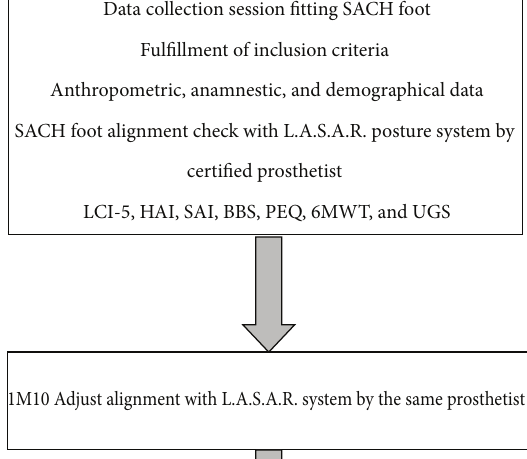
Figure 4: Box-plots for the nine subscales scores of the Prosthesis Evaluation Questionnaire (PEQ). The boxes show the lower quartile, median(boldline),andupperquartilevalues,thewhiskersrepresent themostextremevalueswithin1.5timestheinterquartilerangefrom the ends of the box, and the circles represent the outliers (data with values beyond the ends of the whiskers). The ordinal data of the nine functional scales of PEQ have been compared between P1 and P2 using Wilcoxon signed rank test.